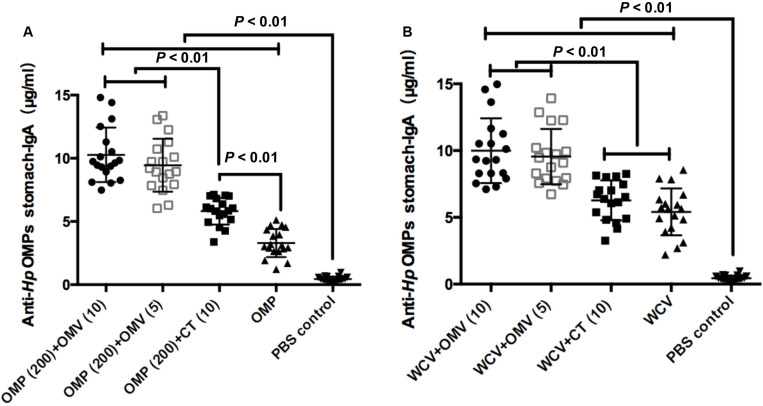
Concentrations of anti-Hp OMP stomach-IgA using OMP as vaccine (A) or WCV (B) from the stomach of mice sacrificed were determined quantificationally by ELISA at week 8. Each group was comprised of 18 mice. These data manifested the strength of mucosal immune response induced by diverse immunogens, which were expressed as means ± SD per group. Least significant difference test was performed to determine whether the distinction between each mean of groups were significant. P < 0.01 represents the difference between the related groups.